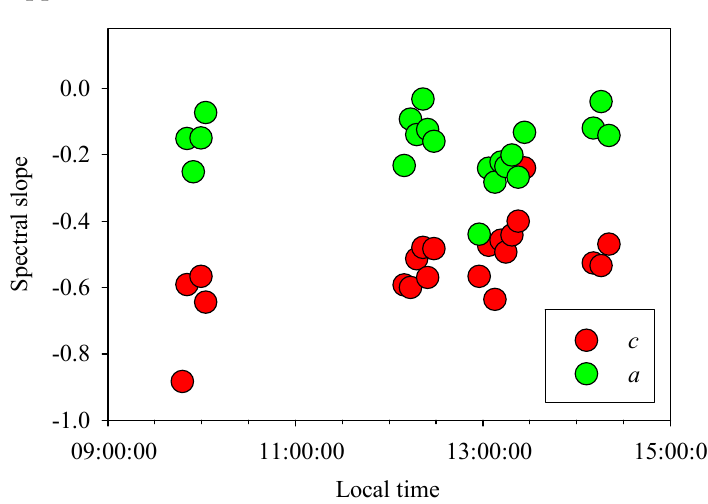
Figure A1. Temporal variability of spectral slopes for IOPs derived from ac-9 and based on Boss et References. Beam attenuation coefficient (red circles), total absorption (water + particulates) coefficient (red circles).